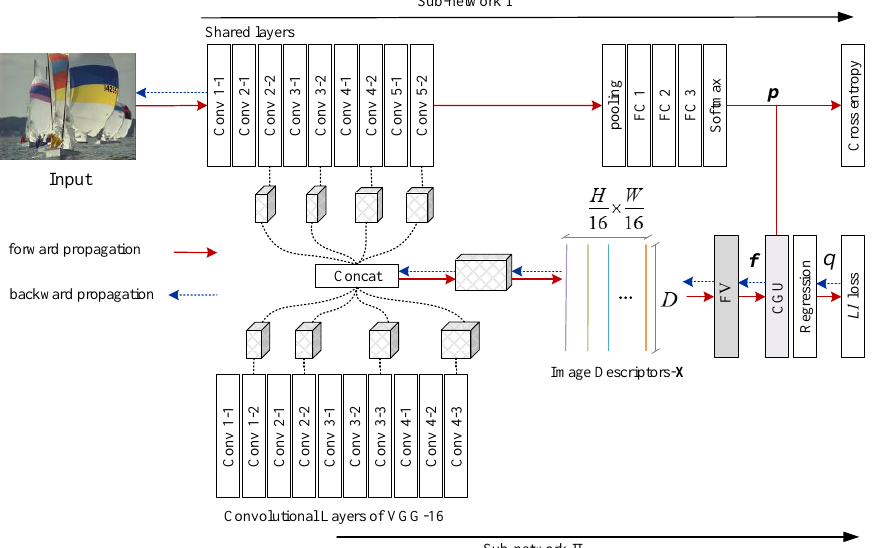
Figure 1. Illustration of CGFA-CNN configurations for BIQA, highlighting the feature aggregation layer (denoted as FV layer) and classification-guided gating unit (denoted as CGU). Features are extracted from the distorted image by Sub-Network